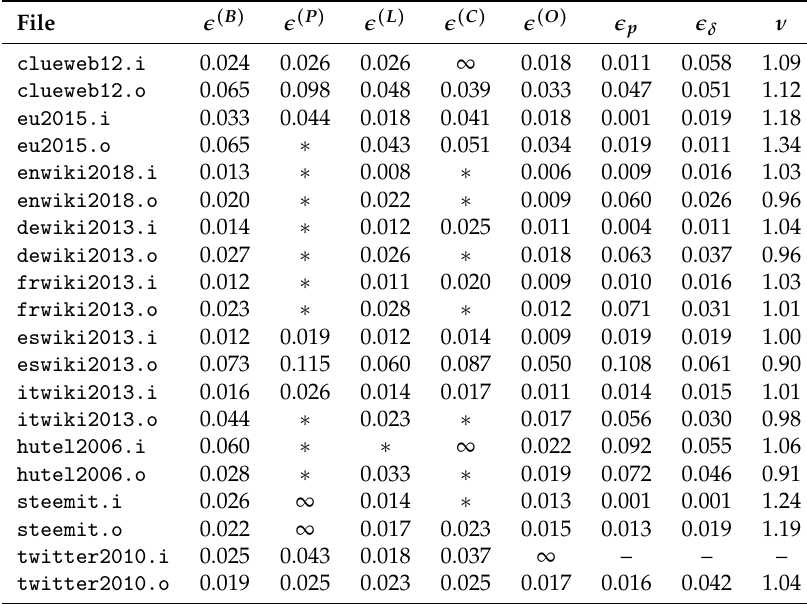
Table 3. Errors and attachment exponents for directed graphs.